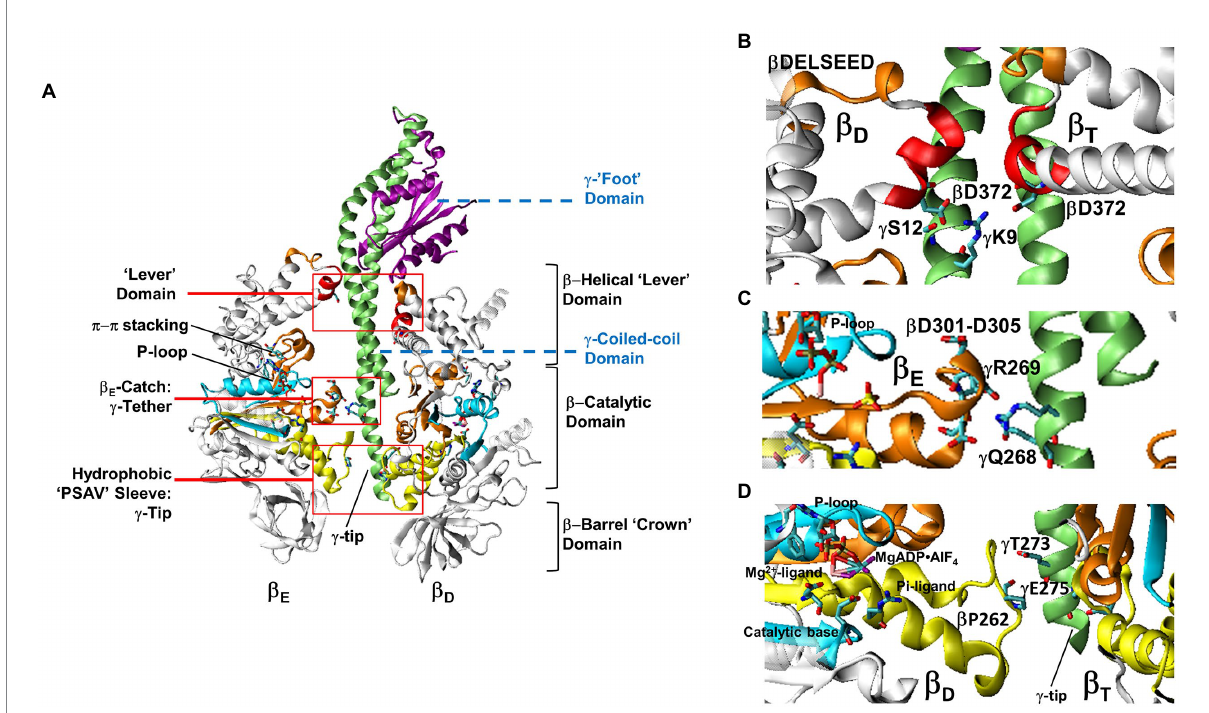
FIGURE 4 Domain composition of F 1 showing the relationship between Mg-nucleotide binding motifs and the stator-rotor interfaces. (A) . Cross-section of F 1 showing the relationship between the β E and β D -subunit conformations and subunit- γ . Red boxes are detailed in (B–D) showing subunit- γ and catalytic site interfaces. (B) . Interactions between the β D and β T -subunit Lever domains and subunit- γ . (C) . Electrostatic interactions between the β E -Catch loop and γ -subunit tether residues. (D) . The short β D and β T -subunit helices that connect the Mg 2+ and Pi ligands of bound MgADP•AlF n transition state analogs with the hydrophobic sleeve surrounding the C-terminal tip of subunit- γ . Images show Bt F 1 structure pdb-ID 1H8E labeled with equivalent Ec F 1 residue numbers to show the location of bound MgADP•AlF n